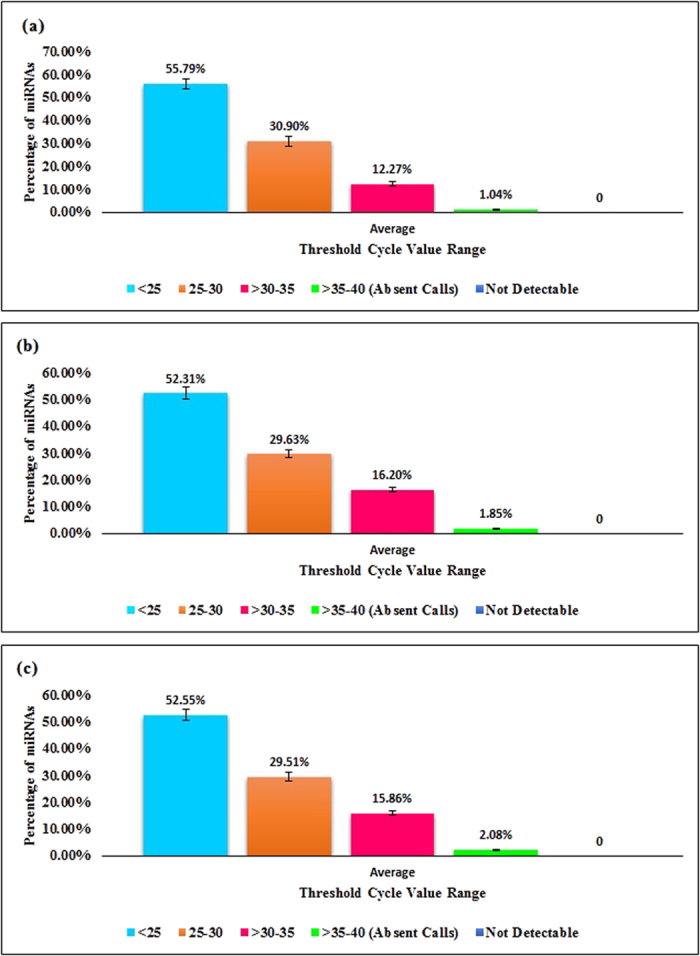
Percent distribution of CT values of boar sperm miRNAs analyzed in three groups [(a) control (Duroc), (b) Group 1 (Yorkshire) and (c) Group 2 (Landrace)]. Note that all miRNAs analyzed were detectable using real-time PCR. The few miRNAs with threshold cycle >35 were omitted from analyses.